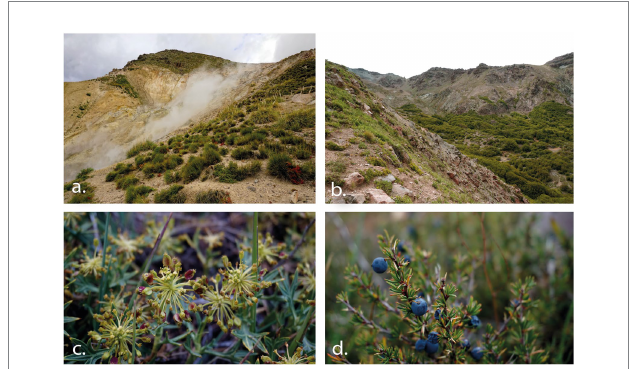
FIGURE 1 Study site located in the Nevados de Chillán Volcanic complex. Letters (A,B) indicate the north and south slopes, respectively. Selected species present on both slopes are indicated on the right side: (C) . A. prolifera and (D) . B. empetrifolia. Credits: Carla